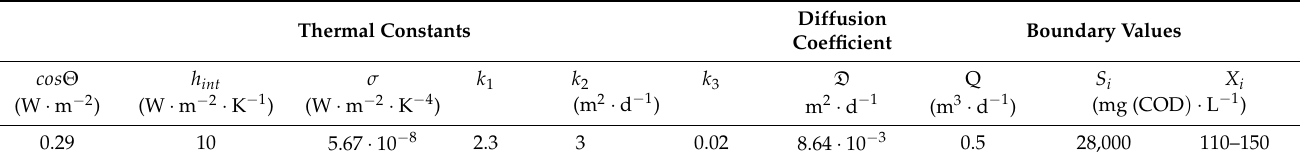
Table 2. General parameters considered. Q represents hydraulic flow in the inlet and outlet pipe. S i and X i represent substrate and cell concentrations in the inlet pipe.